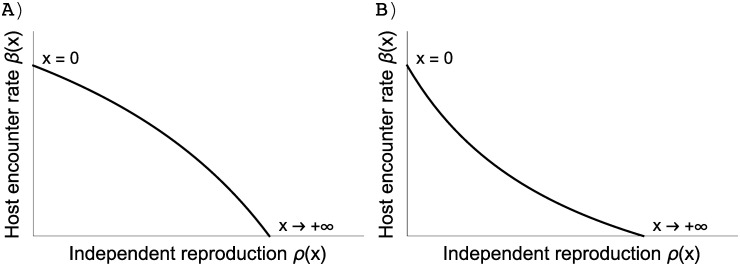
Relationship between β and ρ, which is derived from the assumption that increasing the investment x in independent reproduction ρ(x) leads to a reduction in host encounter rate β(x).Host encounter rate and independent reproduction are functions of the investment such that β(x) = βmax/(αx + 1); ρ(x) = ωx/(δx + 1). Depending on the parameters, the resulting trade-off can be convex (A) α = 0.7, δ = 1.3 or concave (B) α = 3.1, δ = 1.3. A convex trade-off curve indicates that investing in host encounter rate does not reduce much reproduction rate, whereas a concave trade-off curve indicates the reverse.